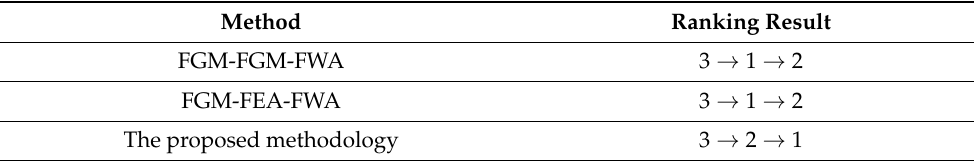
Table 9. Comparison of ranking results using various methods (Scenario